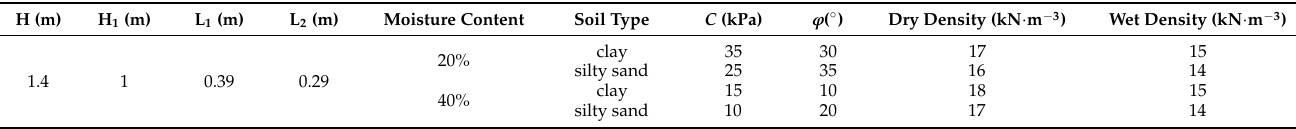
Table 3. Model parameters for simulating the failure mode.